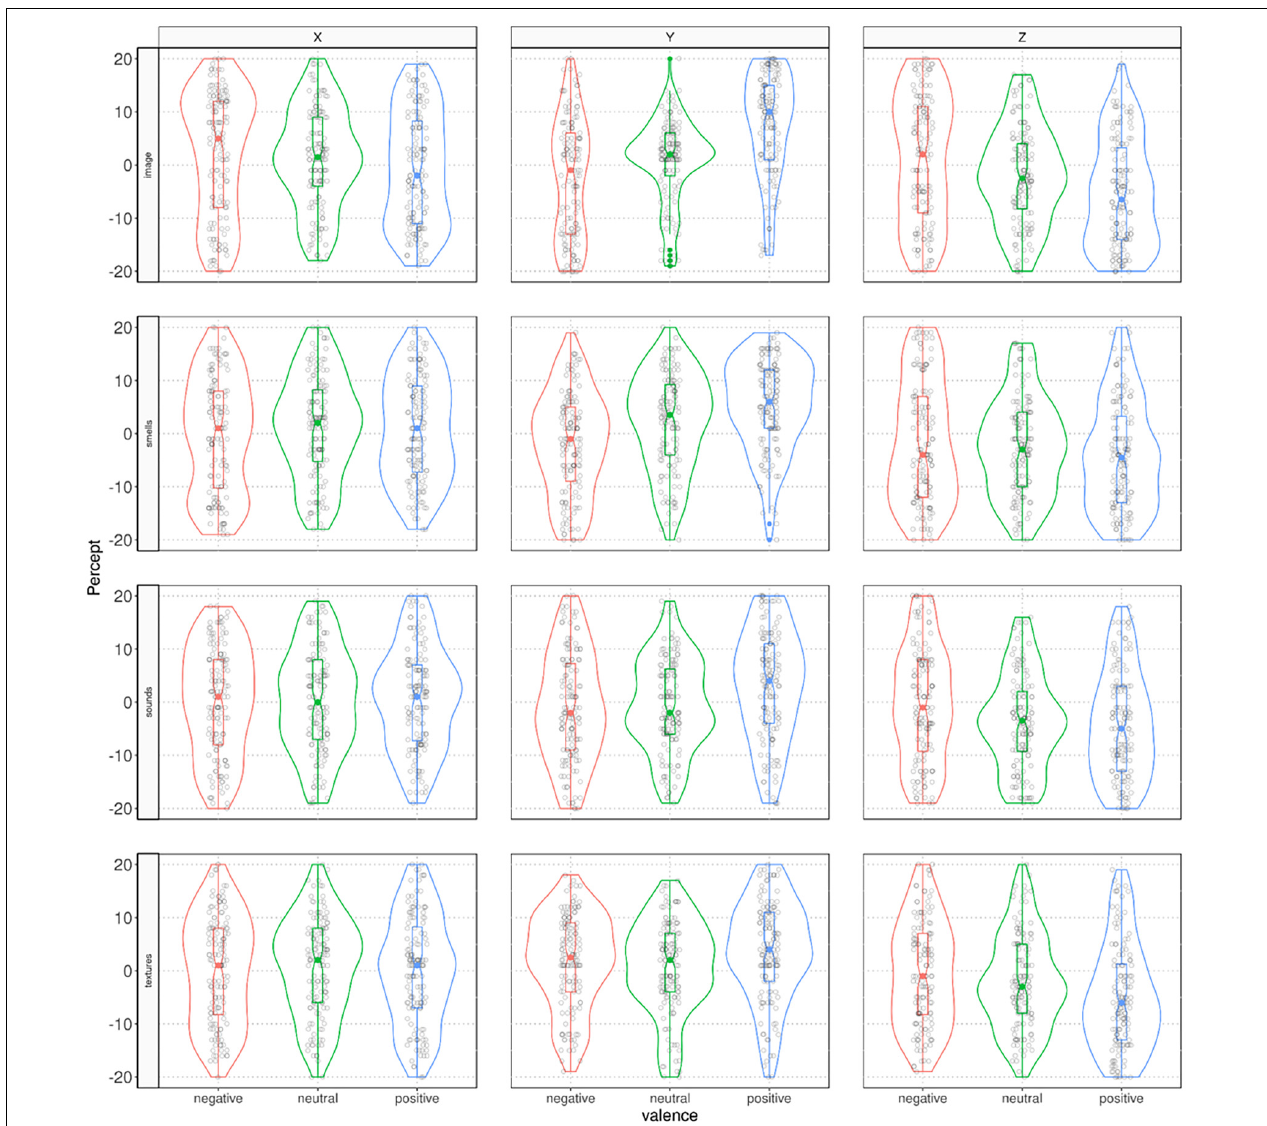
FIGURE 3 | Violin-plots displaying the distribution of locations of valenced stimuli in each sensory modality in the X , Y , and Z spatial